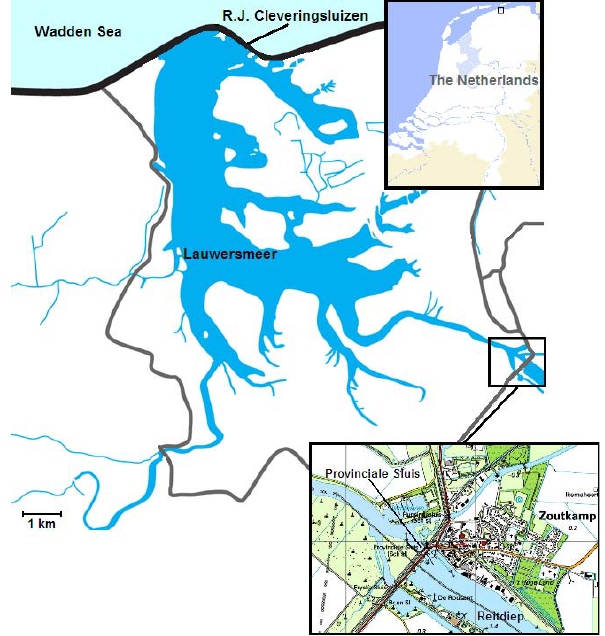
Fig. 1. Map of the Lauwersmeer; the dark grey lines represent the surrounding